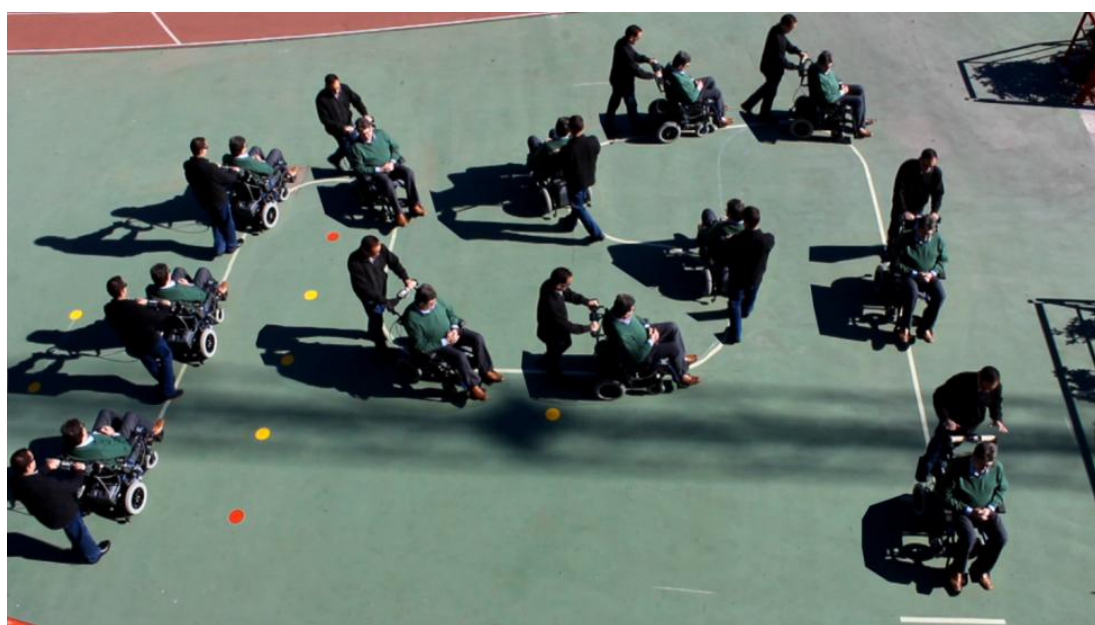
Figure 22. Test path: third